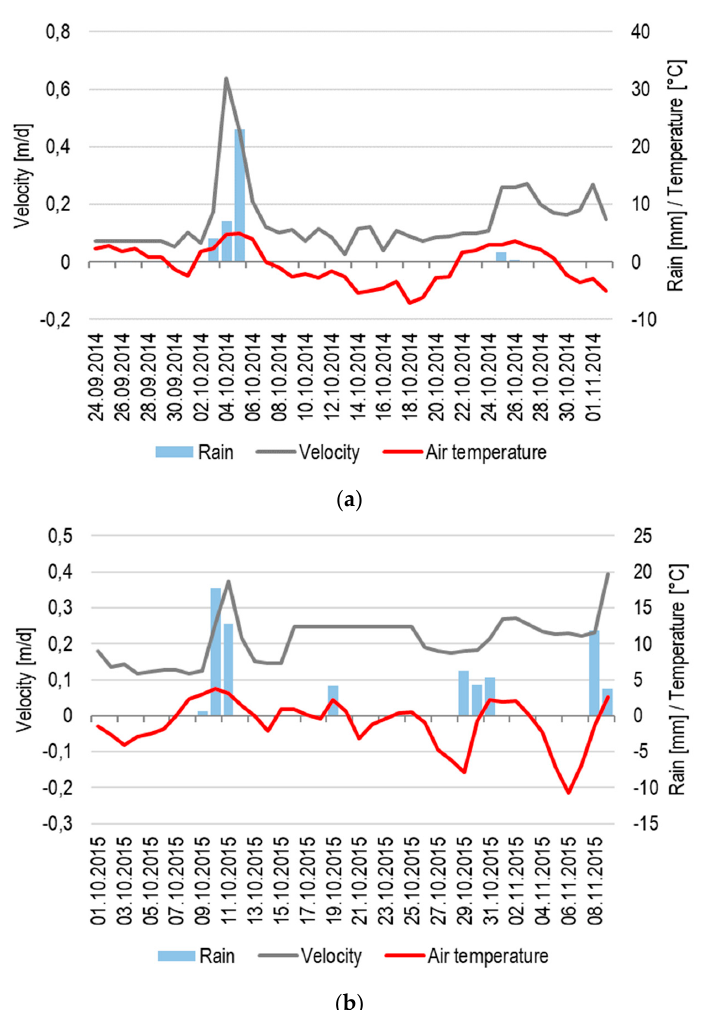
Figure 6. Average daily changes in Hansbreen velocity (grey line) from the 24th of September to 11th of November 2014 ( a ), and 1st of October to 11th of November 2015 ( b ), with clear speed-up events related to intense winter rainfall, daily totals of winter rain (06 ‒ 06 UTC, blue bars), and air temperatures (red line).